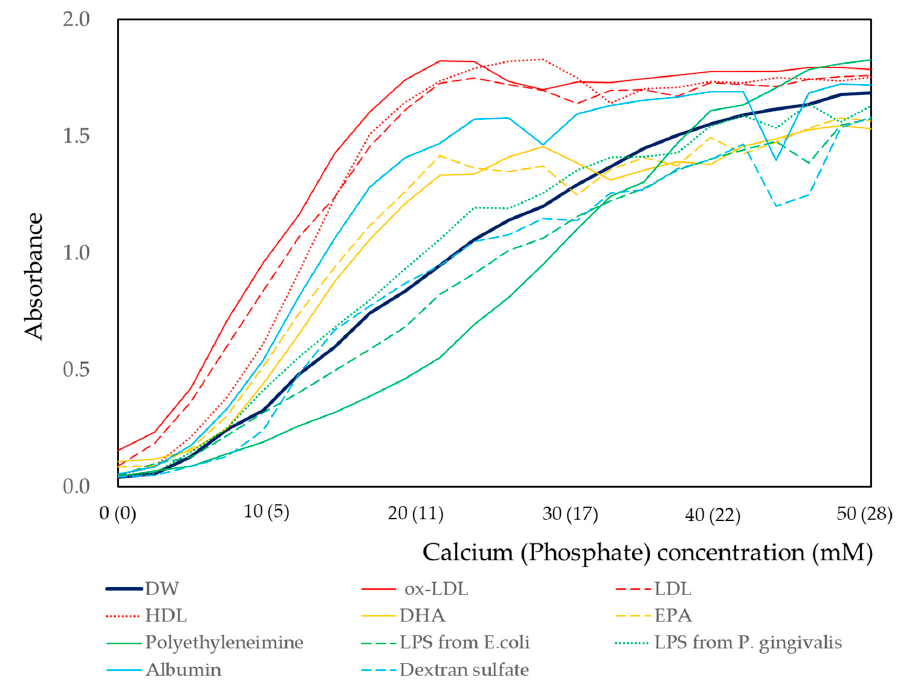
Figure 2. Effect of the biomaterials on calcium and phosphate reaction. Absorbance values were at a wavelength of 650 nm. DW: Deionized water, LDL: Low-density lipoprotein, HDL: high-density lipoprotein, DHA: Docosahexaenoic acid, EPA: Eicosapentaenoic acid, LPS: lipopolysaccharides. Table 1. Effect of the biomaterials on the reaction of calcium and phosphate.